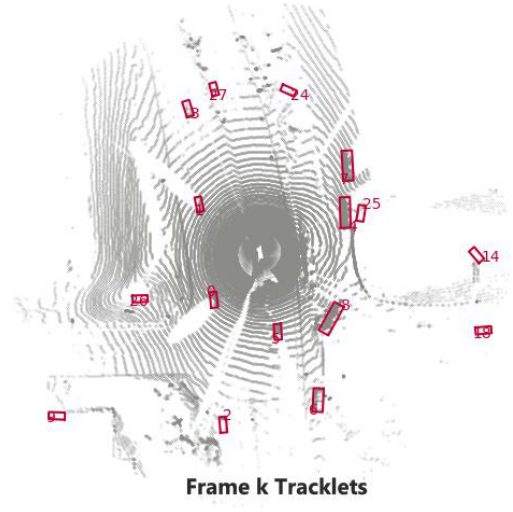
Figure 4. Motion prediction process.